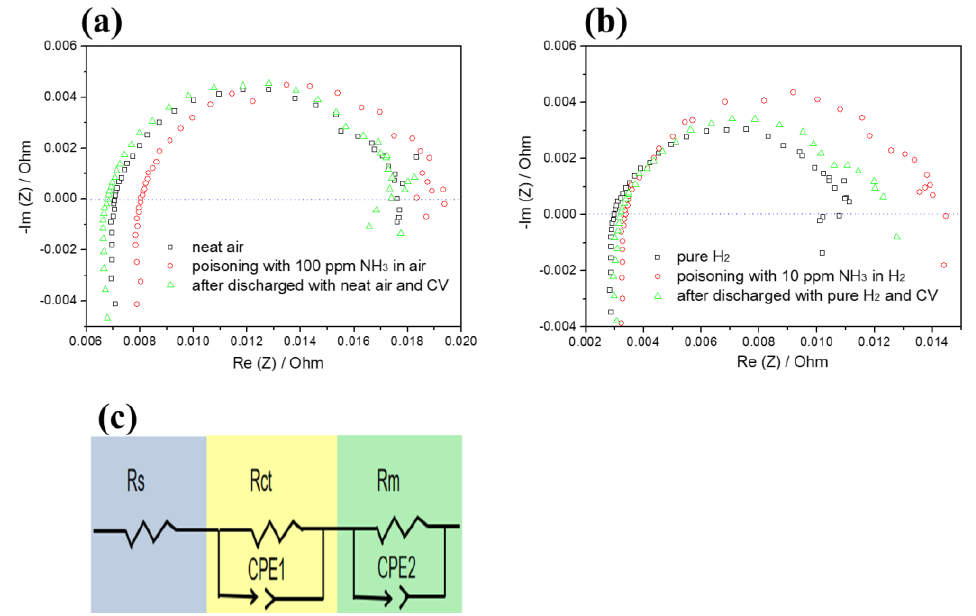
Figure 8. Nyquist plots of the impedance spectra measured before and after a cell poisoning with NH 3 in air ( a ) and fuel ( b ); ( c ) the equivalent circuit. Table 1. The electrochemical parameters of the MEAs under different conditions.